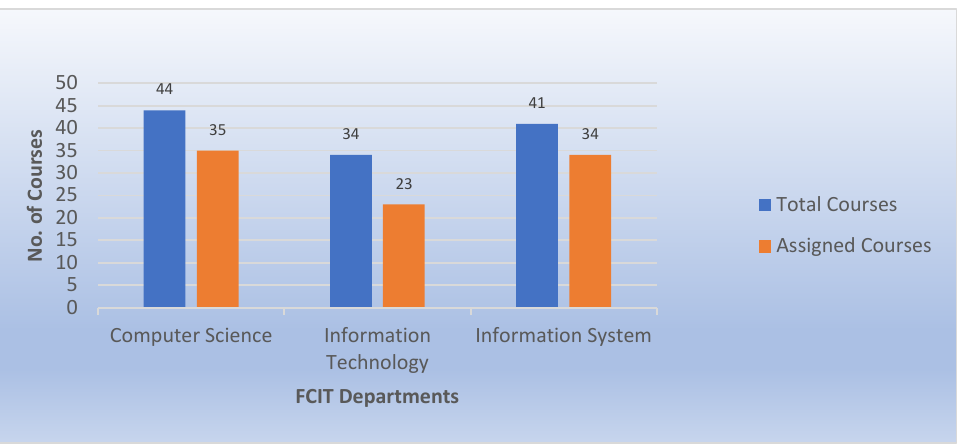
Figure 16. Comparing number of courses assigned to teachers using LD to the total number of